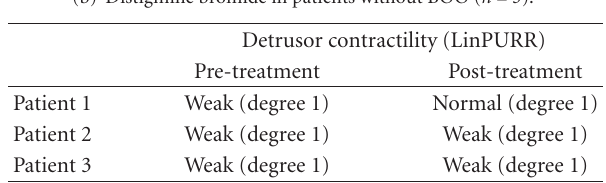
BOO, bladder outlet obstruction (2) LinPURR, linear passive urethral resistance